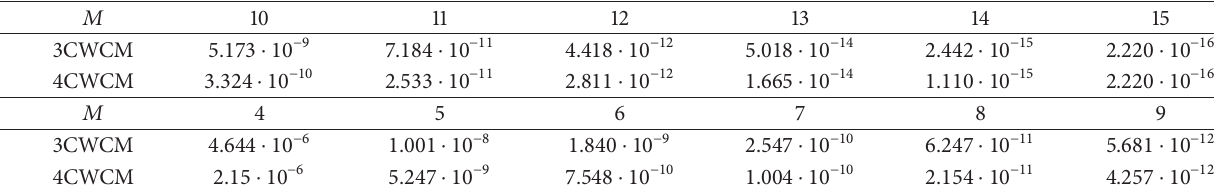
Table 2: The maximum absolute error 𝐸 for Example 2.